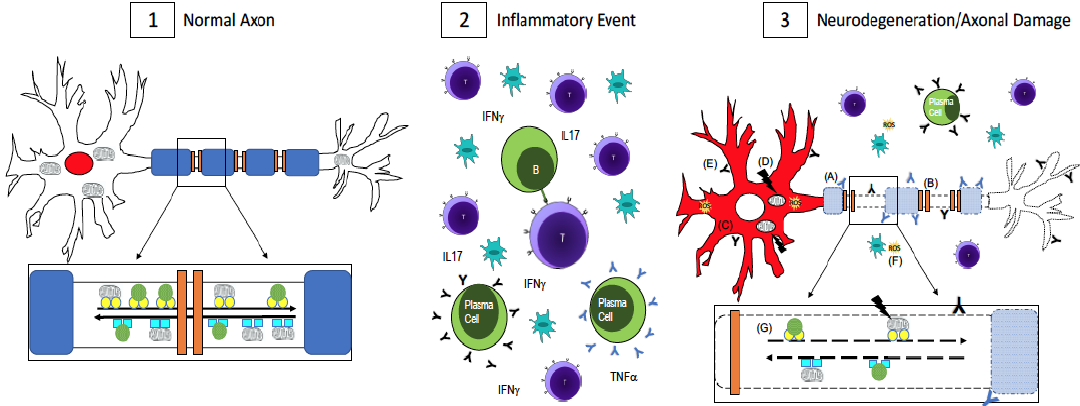
Figure 1. Axonal Damage in multiple sclerosis (MS). ( 1 ) In a normal, healthy axon, myelin (blue) wraps around the axon and ion channels (orange) are clustered in the unmyelinated nodes of Ranvier. This enables saltatory conduction for fast signal transmission down the axon. RNA binding proteins, which maintain RNA homeostasis, are localized to the nucleus (red). Mitochondria and other cargo (green circles) are transported retrogradely along the axon by dynein (turquoise squares, inset) while anterograde transport is done by kinesin motor proteins (yellow circles, inset). Transport is fast and uninterrupted because the axon is undamaged, has no energy shortage, and the motor proteins are intact; ( 2 ) In MS, there is central nervous system infiltration of T-cells, B-cells, plasma cells, and macrophages, which lead to a cascade of events including the release of pro-inflammatory cytokines and antibodies, which are thought to be harmful to both myelin and neurons and axons. [43–49]; ( 3 ) Axonal damage and neurodegeneration occur simultaneously with inflammation. There is ongoing demyelination due to antibodies against myelin antigens (blue Y, A) [43–45]. Demyelination leads to the redistribution of ion channels (B), which impairs conduction along the axon [32,33]. The redistribution of RNA binding proteins from their normal nuclear location (panel 1, red) to the cytoplasm (panel 3, C, red) is a pathological feature of neuronal degeneration in neurological diseases [25–28,30,31]. Mutations in mitochondrial DNA (D) can impair the cell’s ability to generate enough ATP while antibodies to non-myelin antigens (black Y, E) damage axons [46–49]. Reactive oxygen species (yellow, F) could be released from activated microglia or as a result of dysfunctional mitochondria [37–41]. Impaired fast axonal transport (G) is also evident in MS [9,34–36]. A combination of these events, as opposed to one in particular, contributes to neurodegeneration and axonal damage in MS.